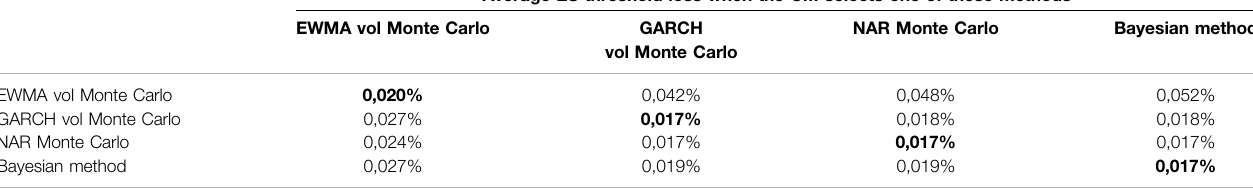
TABLE 5 | Comparative average of losses below the ES